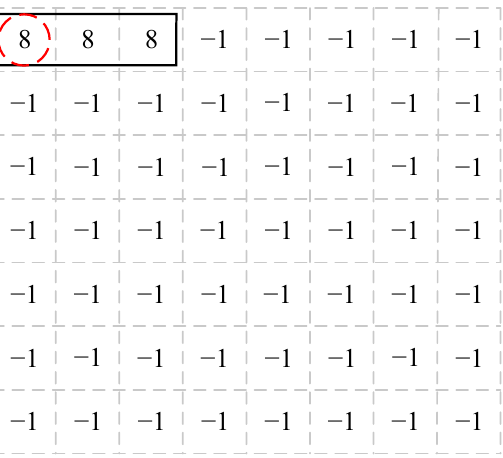
Figure 3. The grid topology and representation of chiplet location.